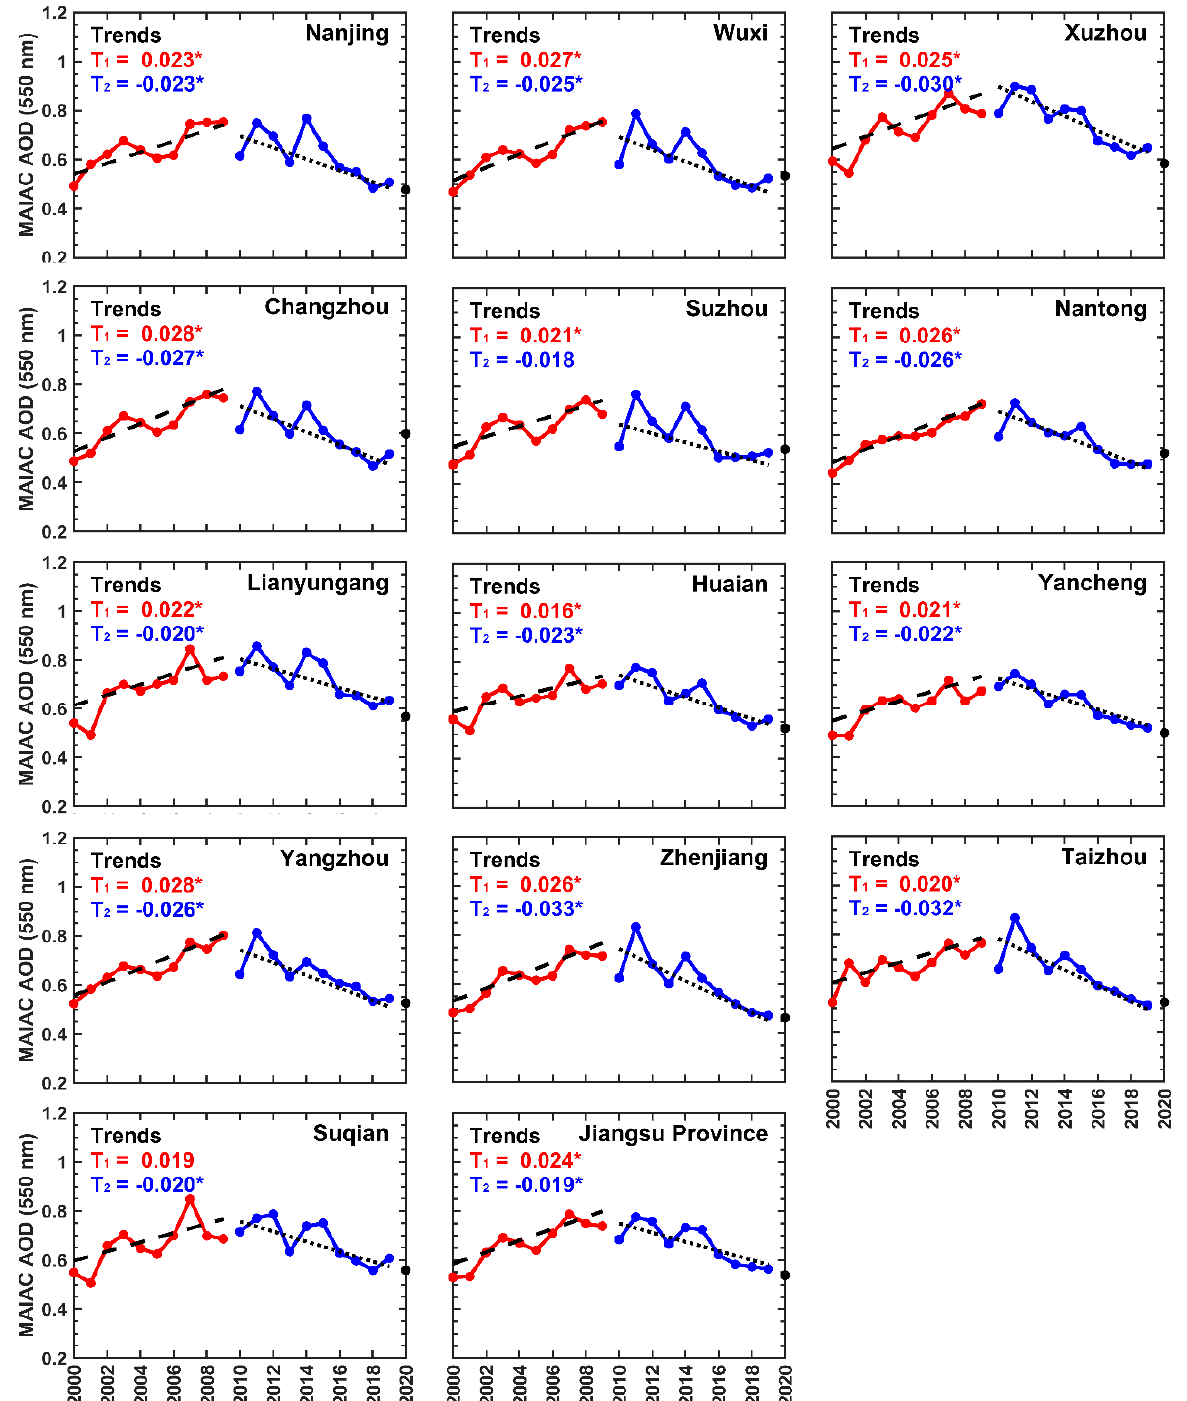
Figure 12. Trends in AOD for the periods of 2000–2009 and 2010–2019 in 13 cities in Jiangsu Province. Here, red indicates an increasing trend and blue indicates a decreasing trend of AOD. Asterisk (*) symbol indicates significance.